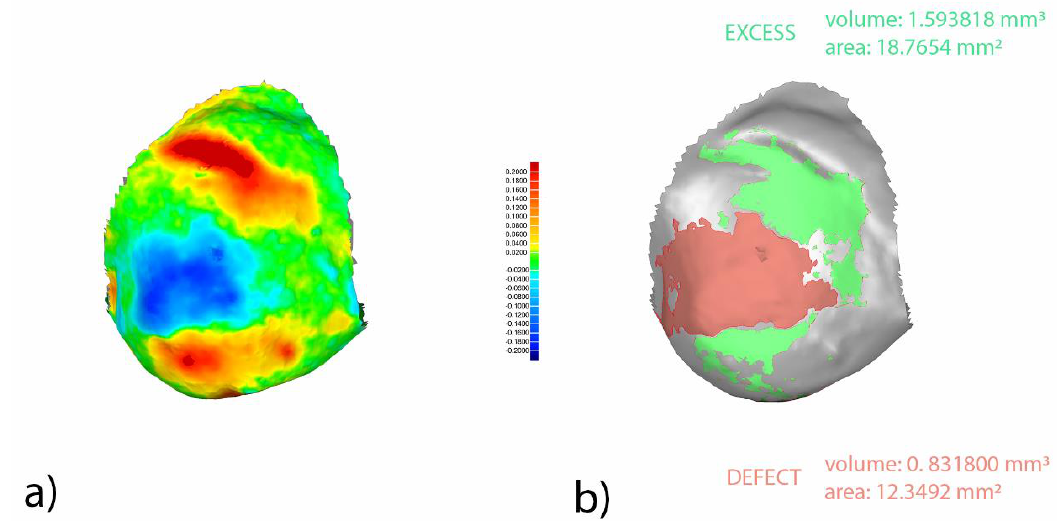
Figure 3. Buccal view of segmented and realigned STL1 and STL3 digital files from tooth 1.5. Warm colors represent a volume increase (remaining cement after cement polishing), cold colors represent a volume decrease (enamel removed after cement polishing), and green represents accurate alignment ( a ). Boundary for the area and volume measurement of the remaining cement after cement polishing (green) and enamel removed after cement polishing (red) ( b ). Current values expressed in millimeters.